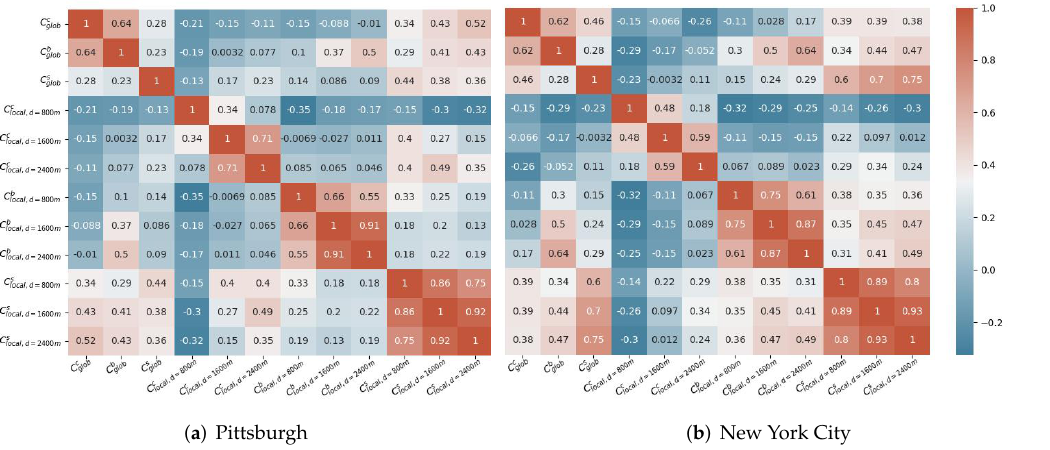
Figure 5. Pair-wise correlation between different centrality measures when considering the road network as an undirected graph. The color bar on the right side shows the range of correlation coefficients with the highest as 1 and the lowest as − 0.35 per our